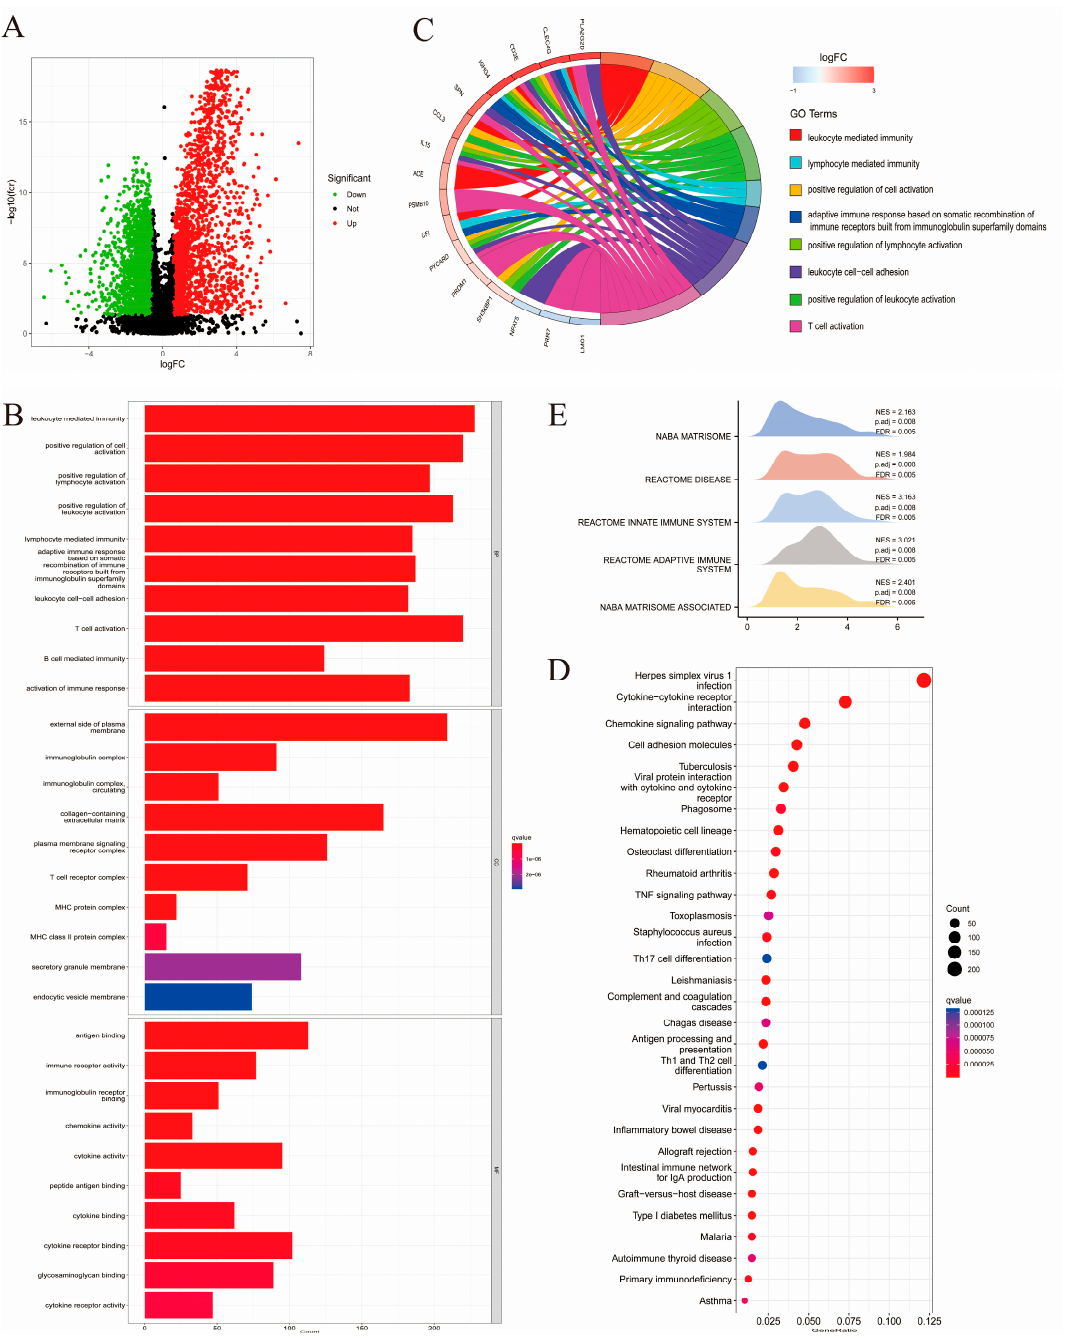
Figure 3. Enrichment analysis performed on DEGs obtained from the two immune subtypes. ( A ) Volcano plot demonstrating the regulation in DEGs expression, with the green, black, red dots rep- resenting down-, not-, and upregulation, respectively. ( B ) The histogram showing the top 10 enriched GO biological processes (BP), cell components (CC), and molecular functions (MF). ( C ) Circle graph presenting the top eight enriched GO terms. ( D ) Bubble chart demonstrating the top 30 enriched KEGG pathways, with the size of dot representing the enriched count. ( E ) Mountain plot listing the top five pathways with the most DEG enrichment according to Gene Set Enrichment Analysis